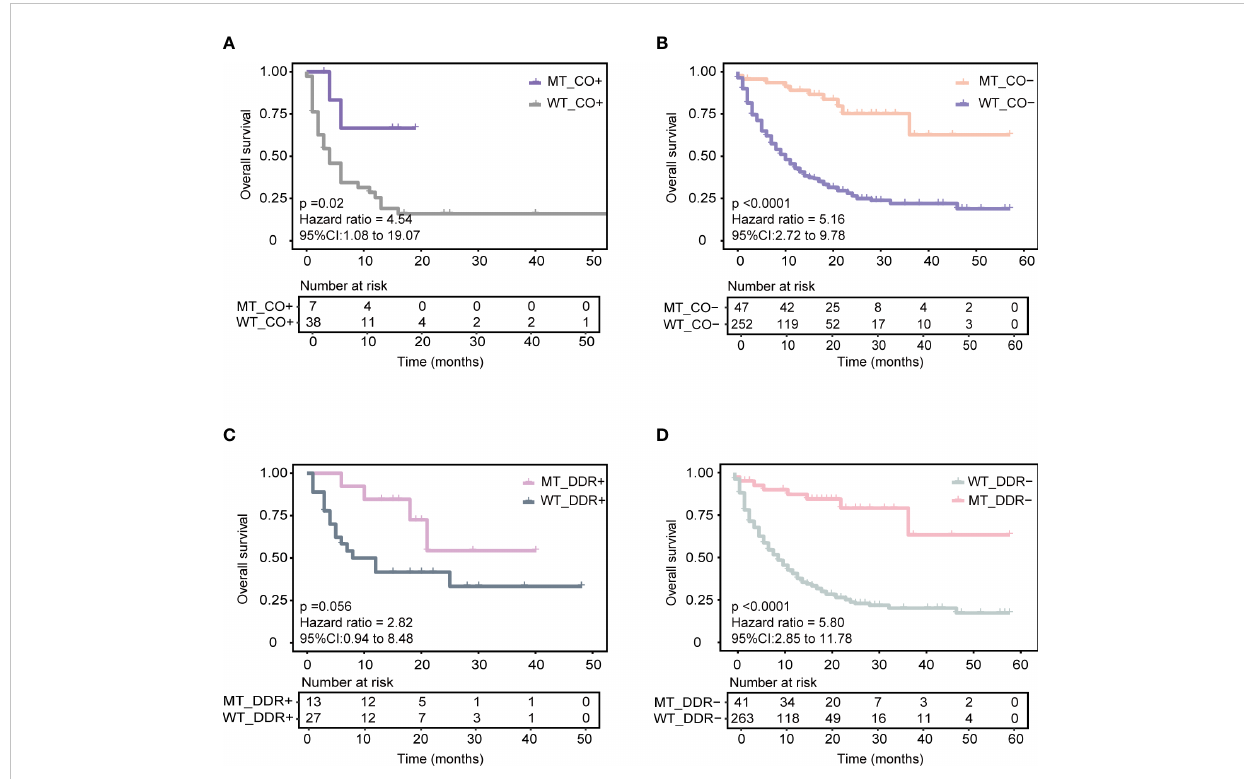
FIGURE 4 Association of our model with other reported biomarkers in predicting ICIs responses based on the training cohort. (A) Predicting the performance of the model in patients with KEAP1- driven co-mutation subgroup (CO+) in the training cohort. (B) Predicting the performance of the model in patients without KEAP1- driven co-mutation subgroup (CO-) in the training cohort. (C) Predicting the performance of the model in patients with more than or equal to one of fi ve DDR gene mutations (DDR+) in the training cohort. (D) Predicting the performance of the model in patients with none of fi ve DDR gene mutations subgroup (DDR-) in the training